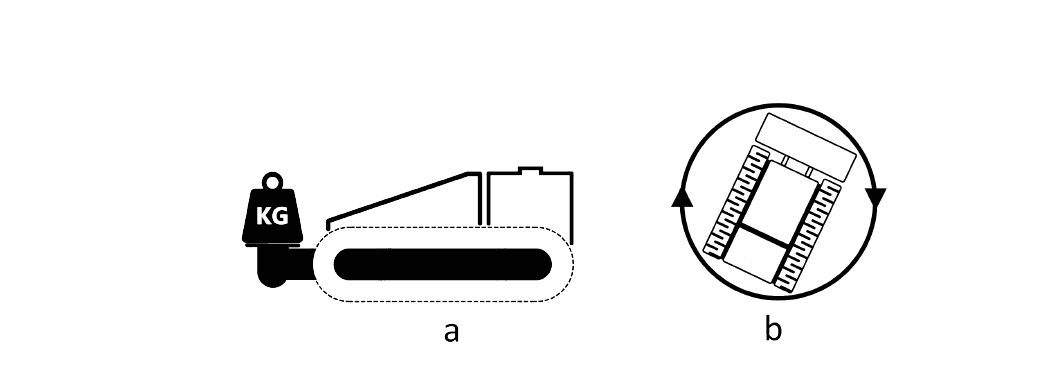
Figure 4. Key metrics: ( a ) payload; ( b ) turning radius.